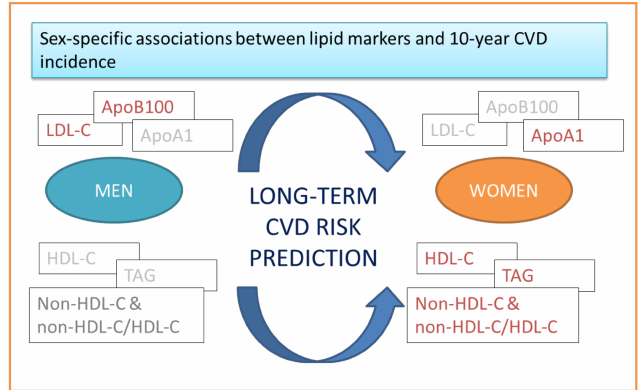
Figure 1. Graphical illustration of the sex-specific association of conventional and non-conventional lipid markers with long-term CVD onset based on results from the ATTICA prospective